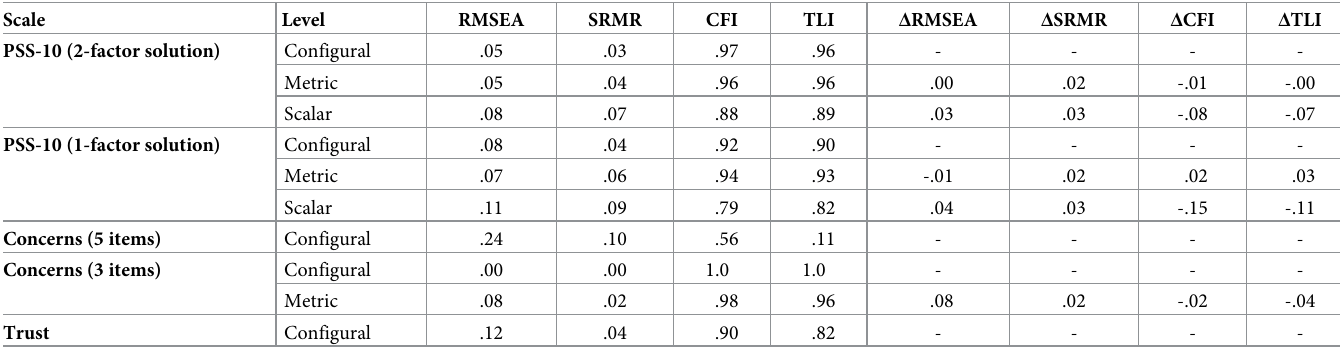
Table 2. Measurement